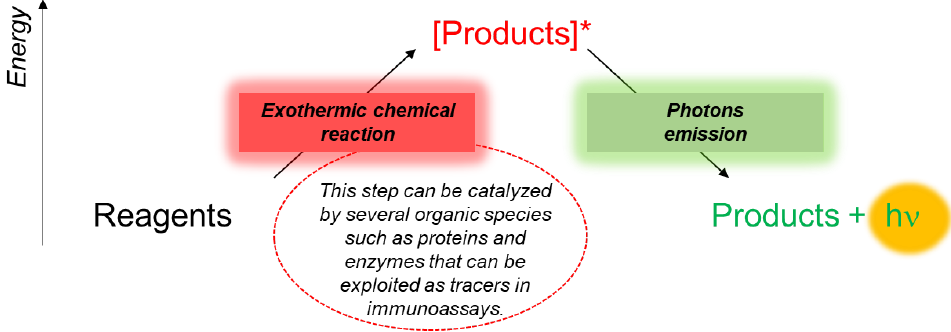
Scheme 1. Schematic representation of bio-chemiluminescent reactions.